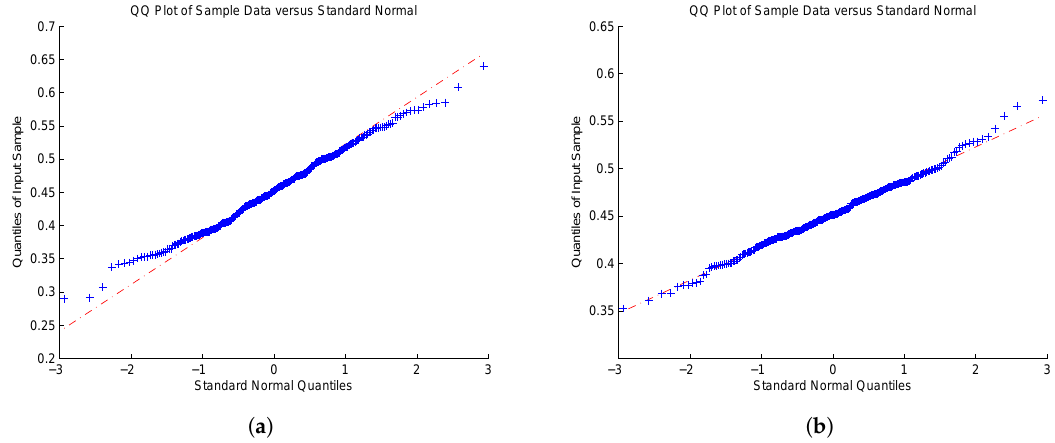
Figure 2. QQ-plot of (cid:98) φ K ( 3 ) for (CP); ( a ) T n = 120, and ( b ) T n =